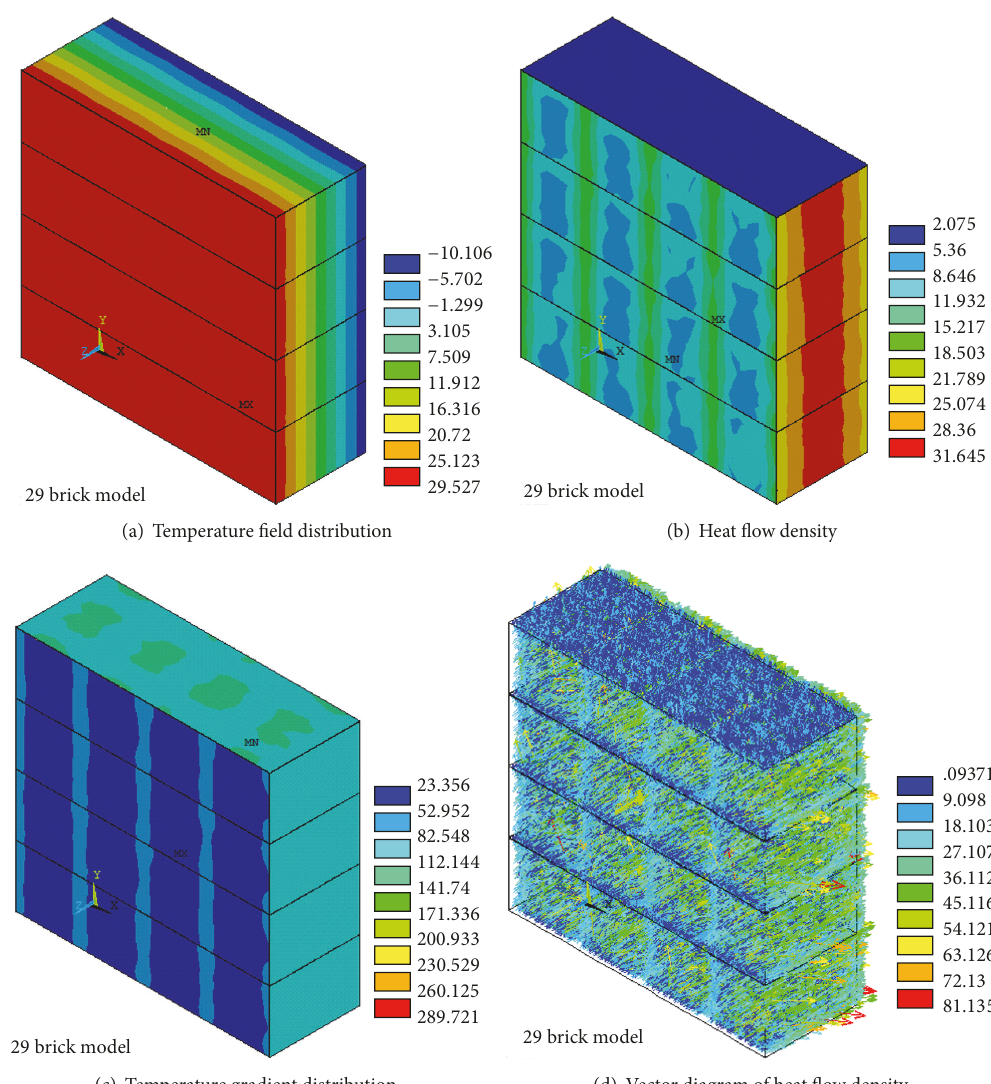
Figure 12: Simulation results for the hollow shale block